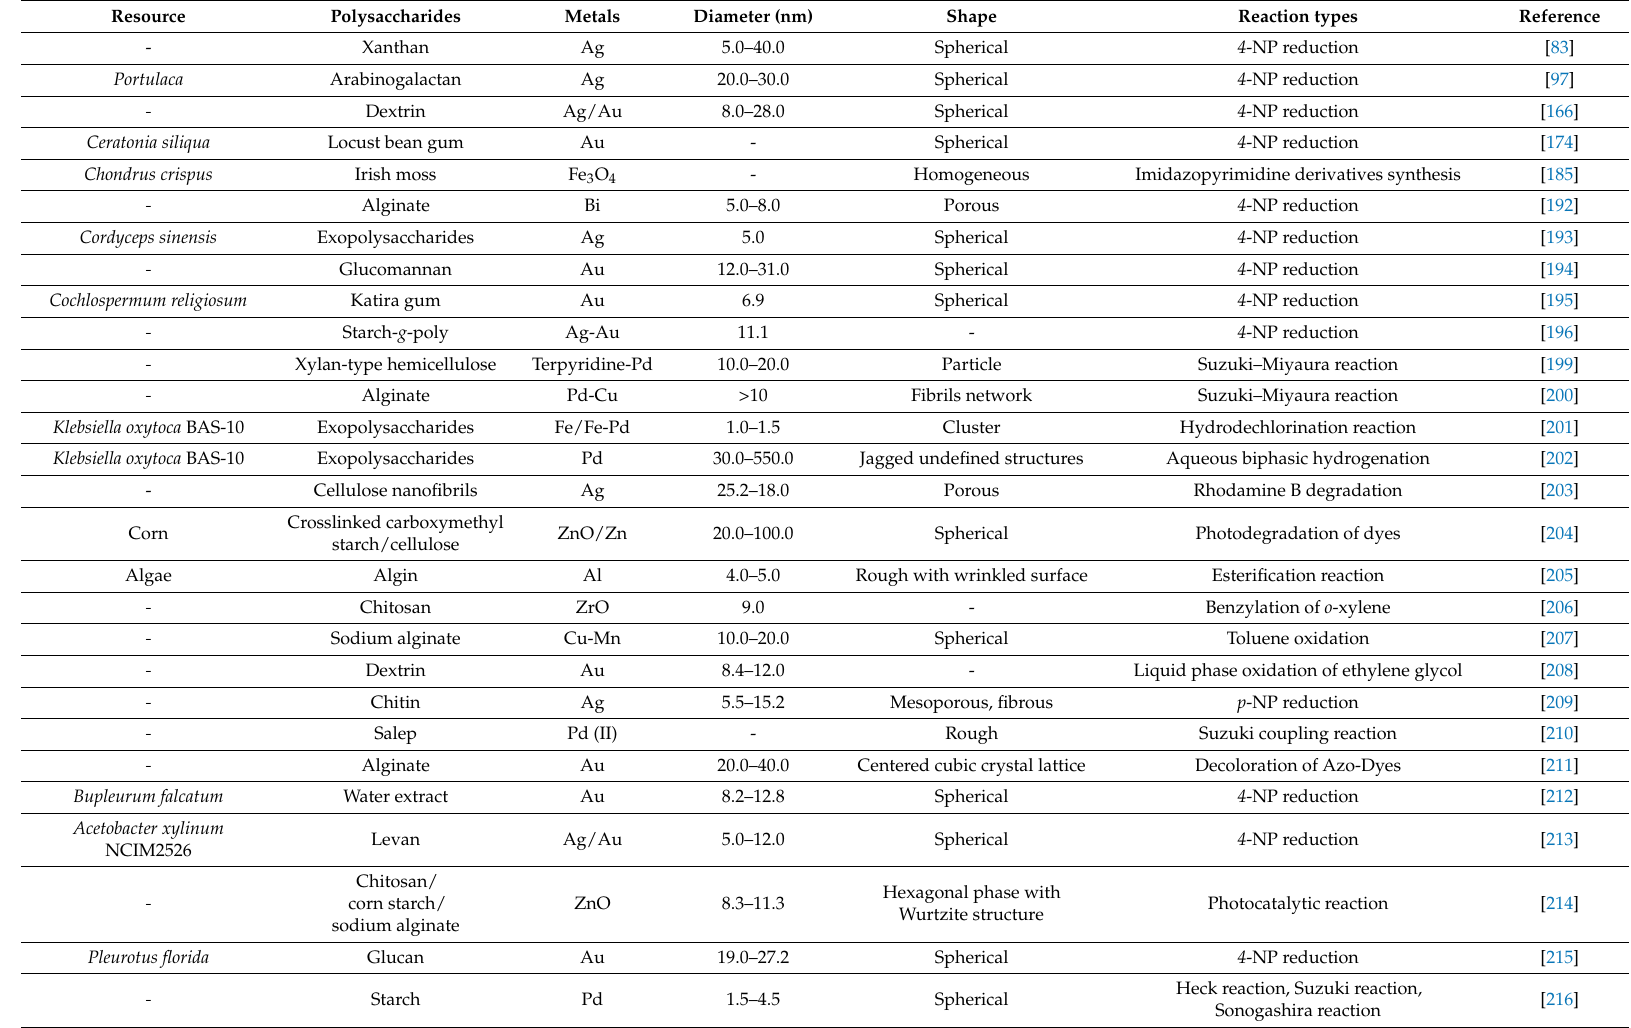
Table 5. Summary of literature data regarding the catalytic property of